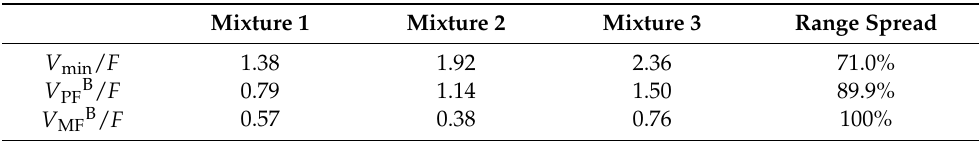
Table 2. Required vapor flowrates in individual mDWC sections for different feed mixtures and calculated range spread.